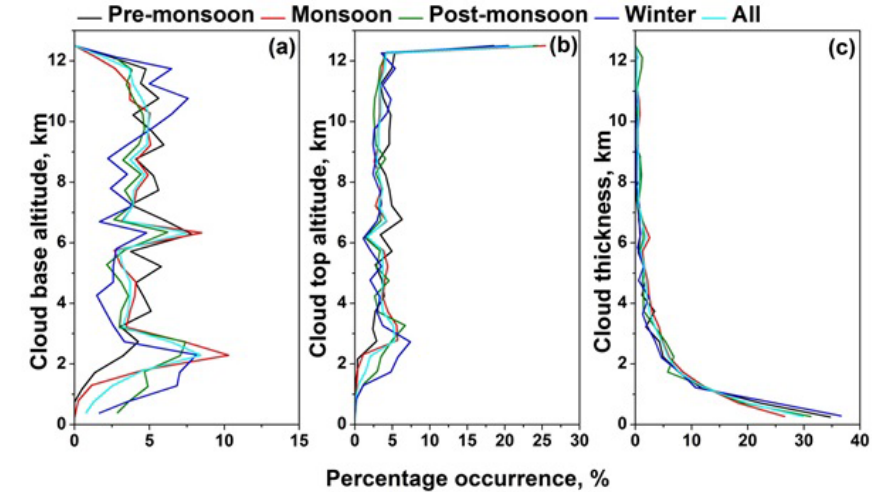
Figure 8. Percentage of occurrence of the (a) cloud base altitude, (b) cloud top altitude, and (c) cloud thickness observed during different seasons over Gadanki. Altitude bin size is 500m.